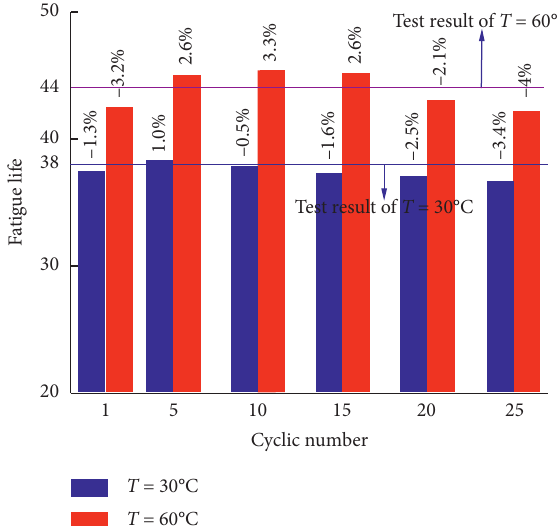
Figure 10: Prediction results of fatigue life.